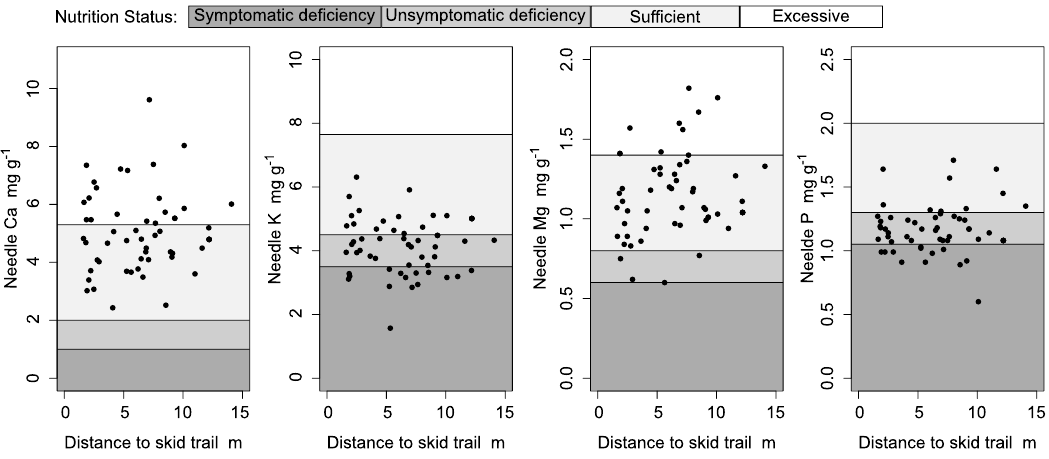
Figure 5. Nutrient concentration in first generation needles in relation to distance from skid trail (2015). Shading refers to nutrition status as classified by Göttlein